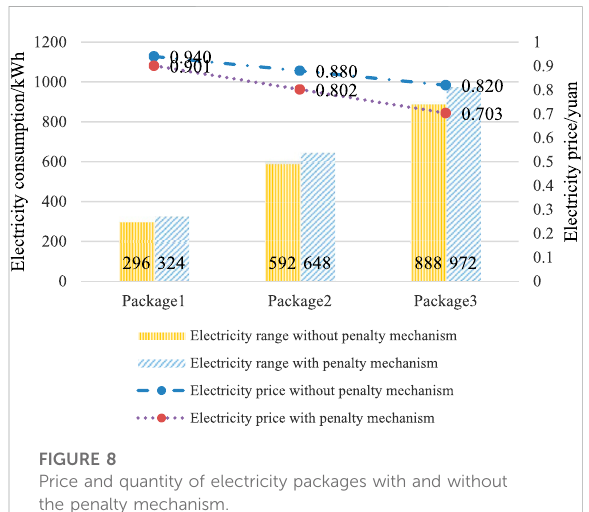
FIGURE 8 Price and quantity of electricity packages with and without the penalty mechanism.